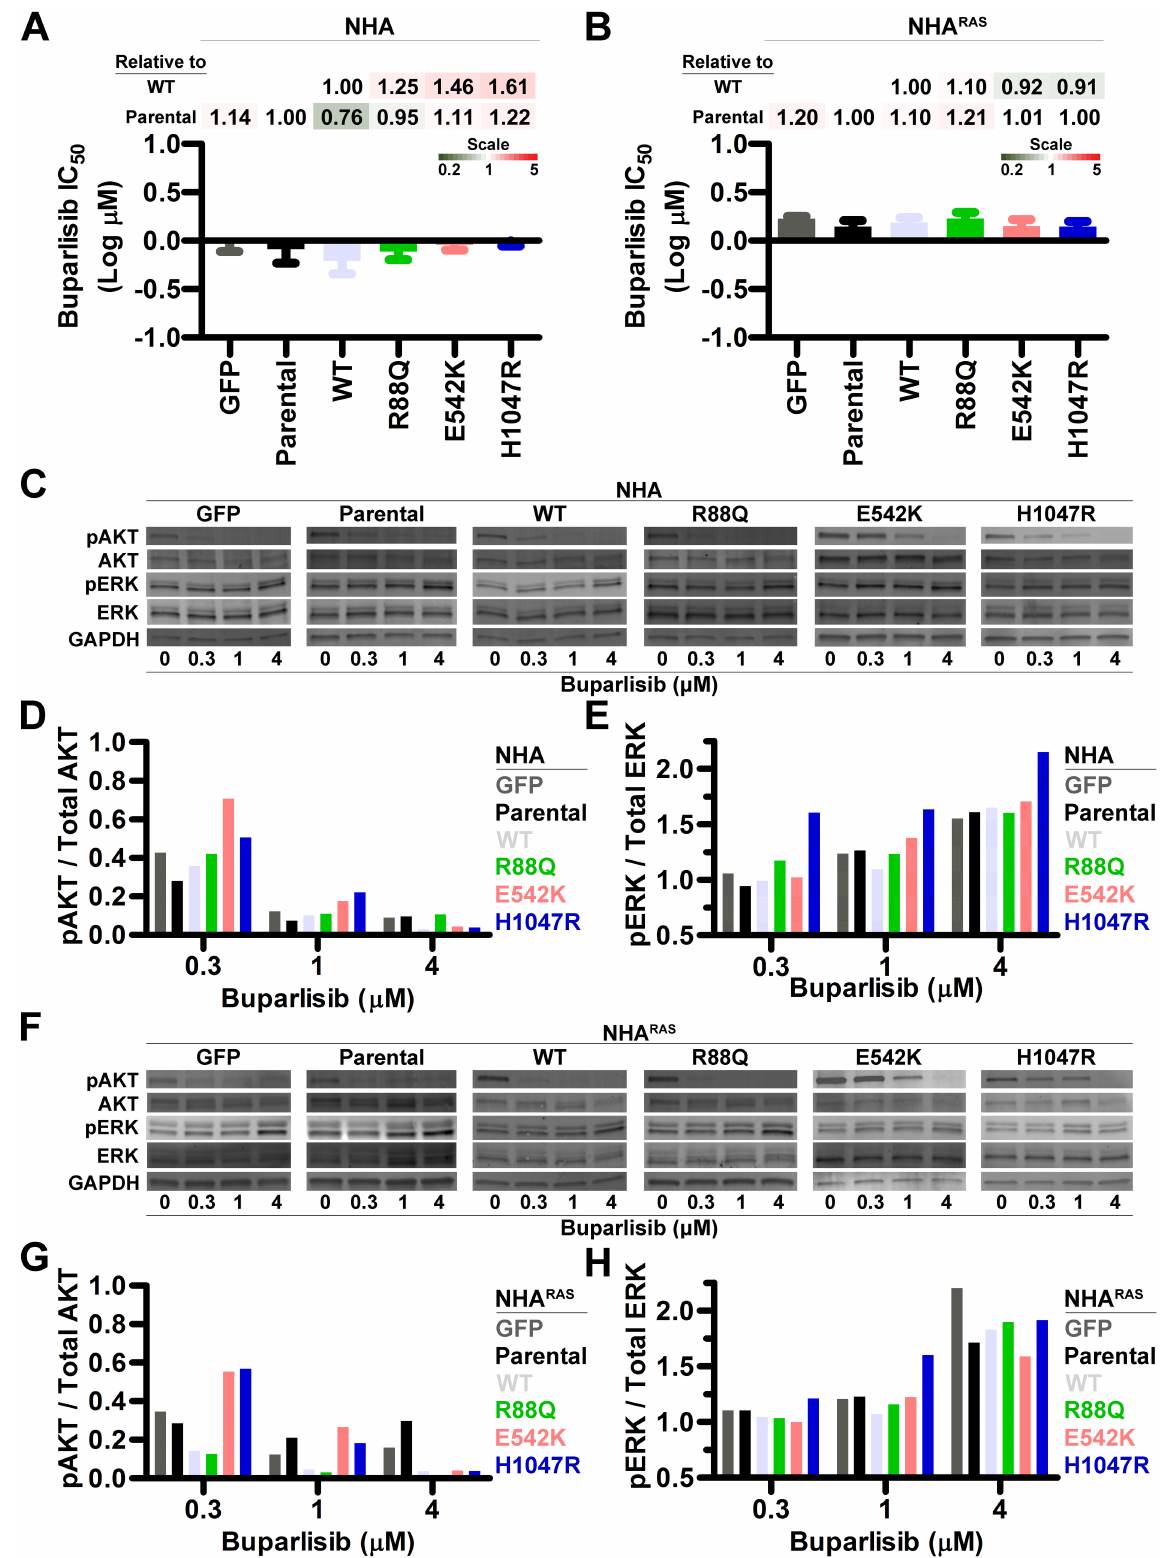
Fig 4. PI3Ki inhibits growth and ablates PI3K regardless of PIK3CA mut status. Buparlisib IC 50 were similar regardless of PIK3CA mut status in NHA ( A ) and NHA RAS ( B ) ( S7 Fig ). Fold changes in IC 50 relative to parental and PIK3CA WT are shown as heatmaps. Representative